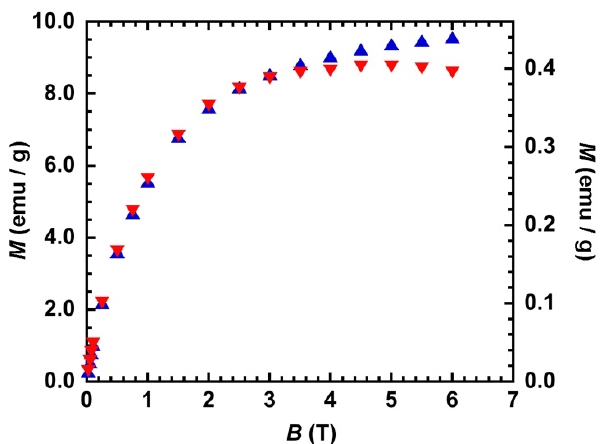
Figure 2. M = f( B ) at T = 2 K before irradiation for CsCoFe_CTA and CsCoFe_PVP. (cid:78) : left scale; (cid:72) : right scale.